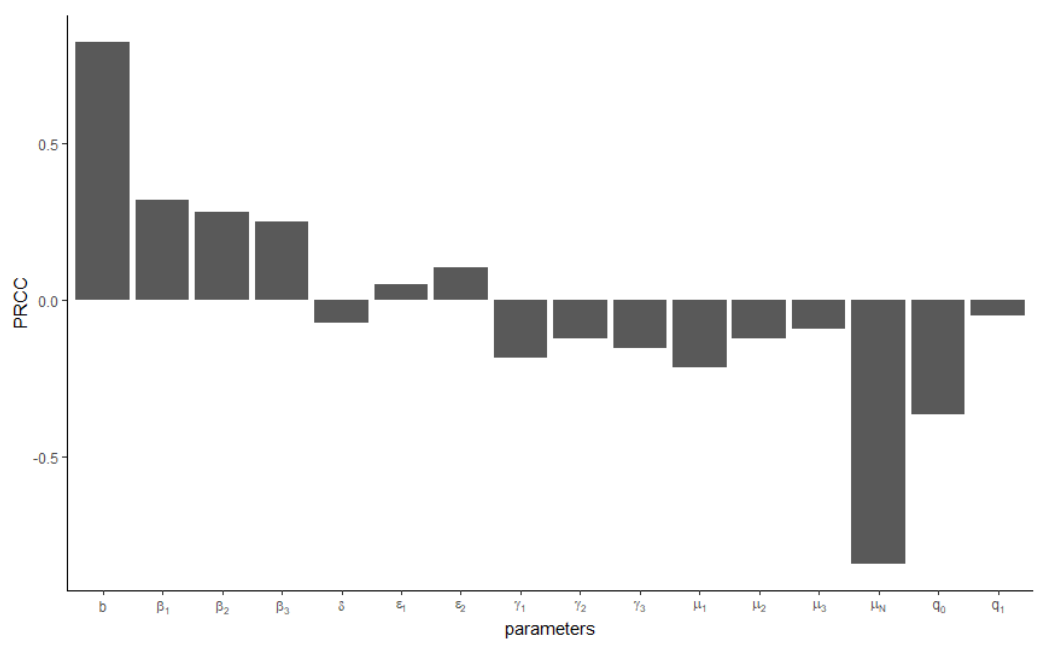
Figure 2. Significance test of 3-train model parameters and PRCC results for 𝑅 0 . Table 2. Partial rank correlation coefficients.